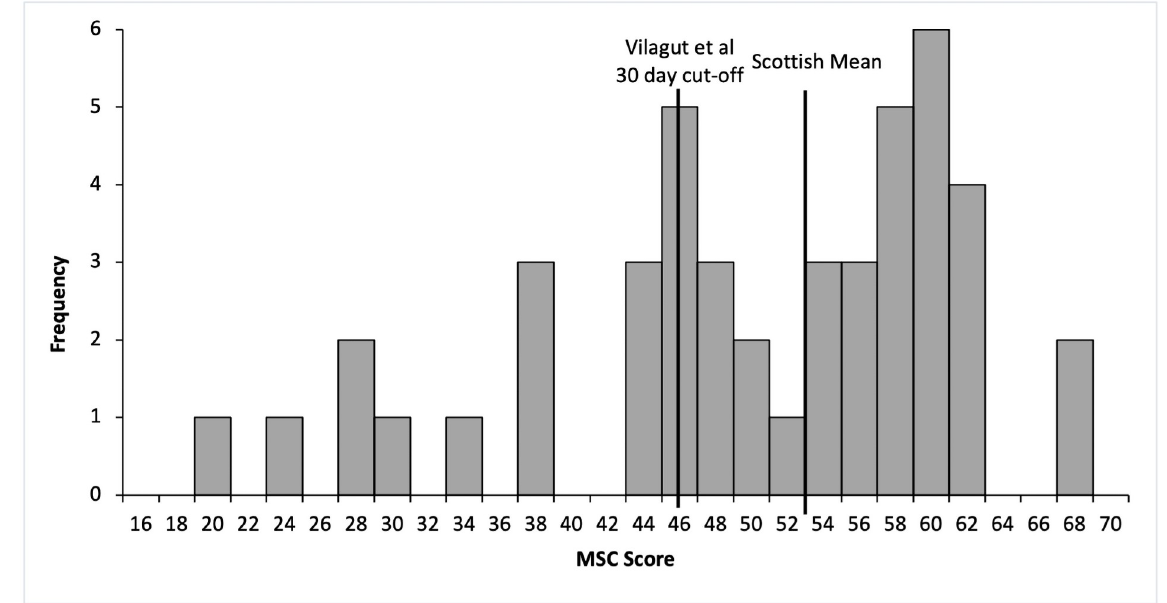
Fig 1. Histogram of patient SF-12 MCS distribution. Scottish adult mean MCS score = 52, Vilagut et al . MCS cut-off for risk of depression within 30 days = 45.6.